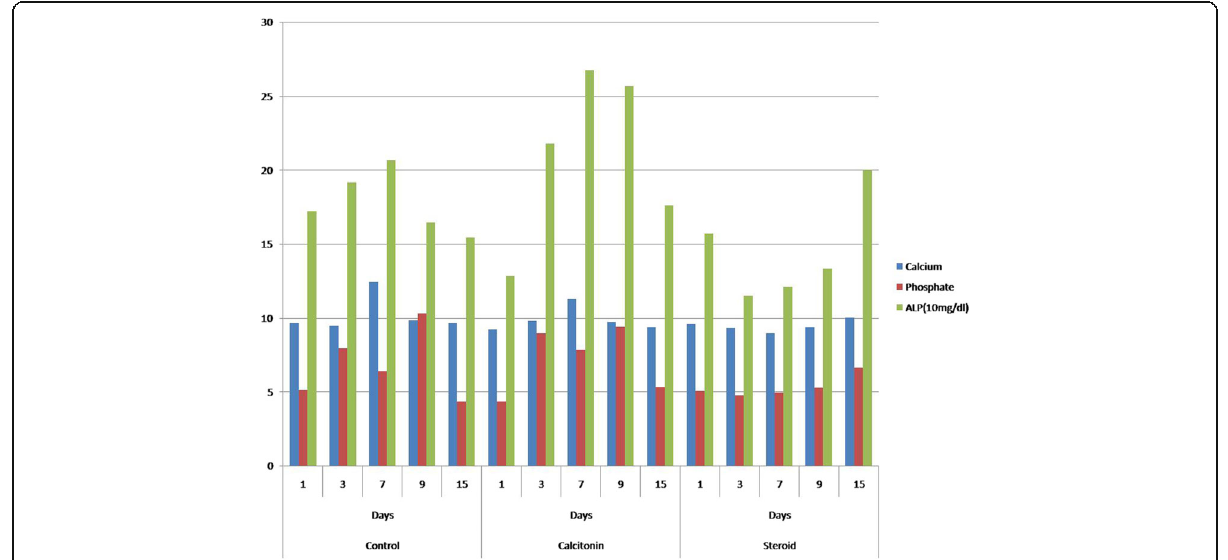
Fig. 4 The boxplot graph of biochemical analysis for the study groups in regard to specific time intervals